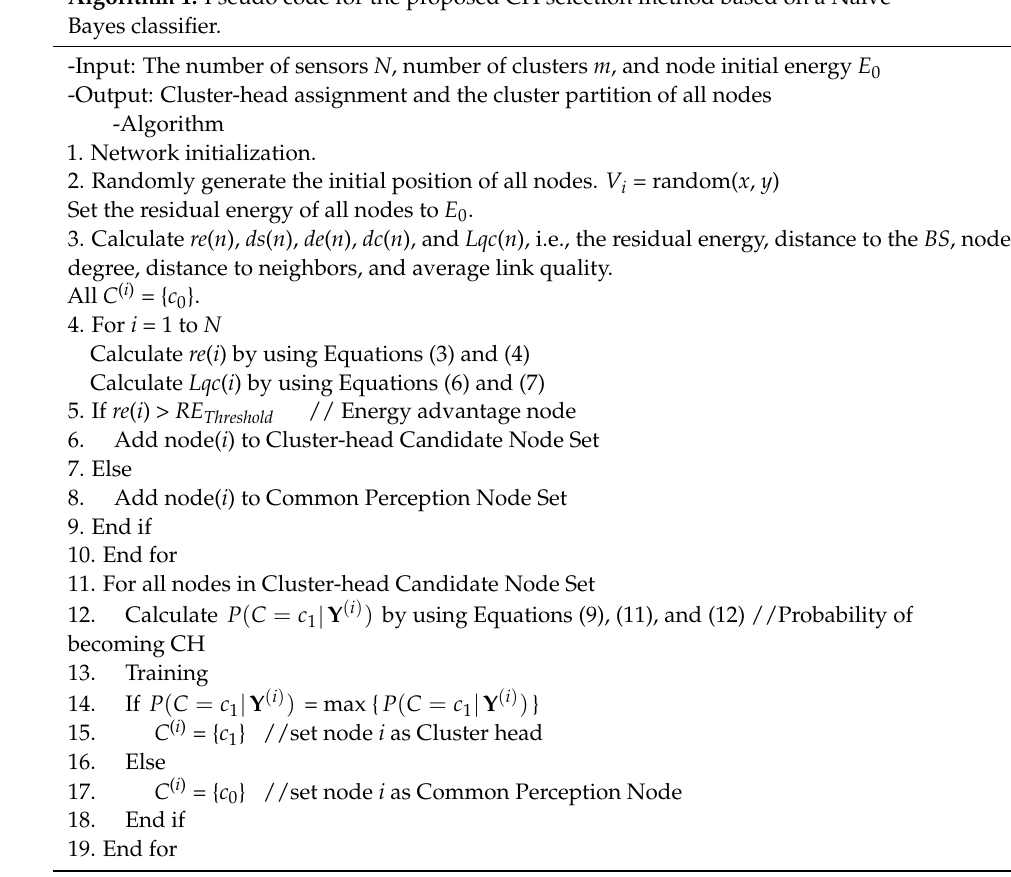
Algorithm 1: Pseudo code for the proposed CH selection method based on a Naïve Bayes